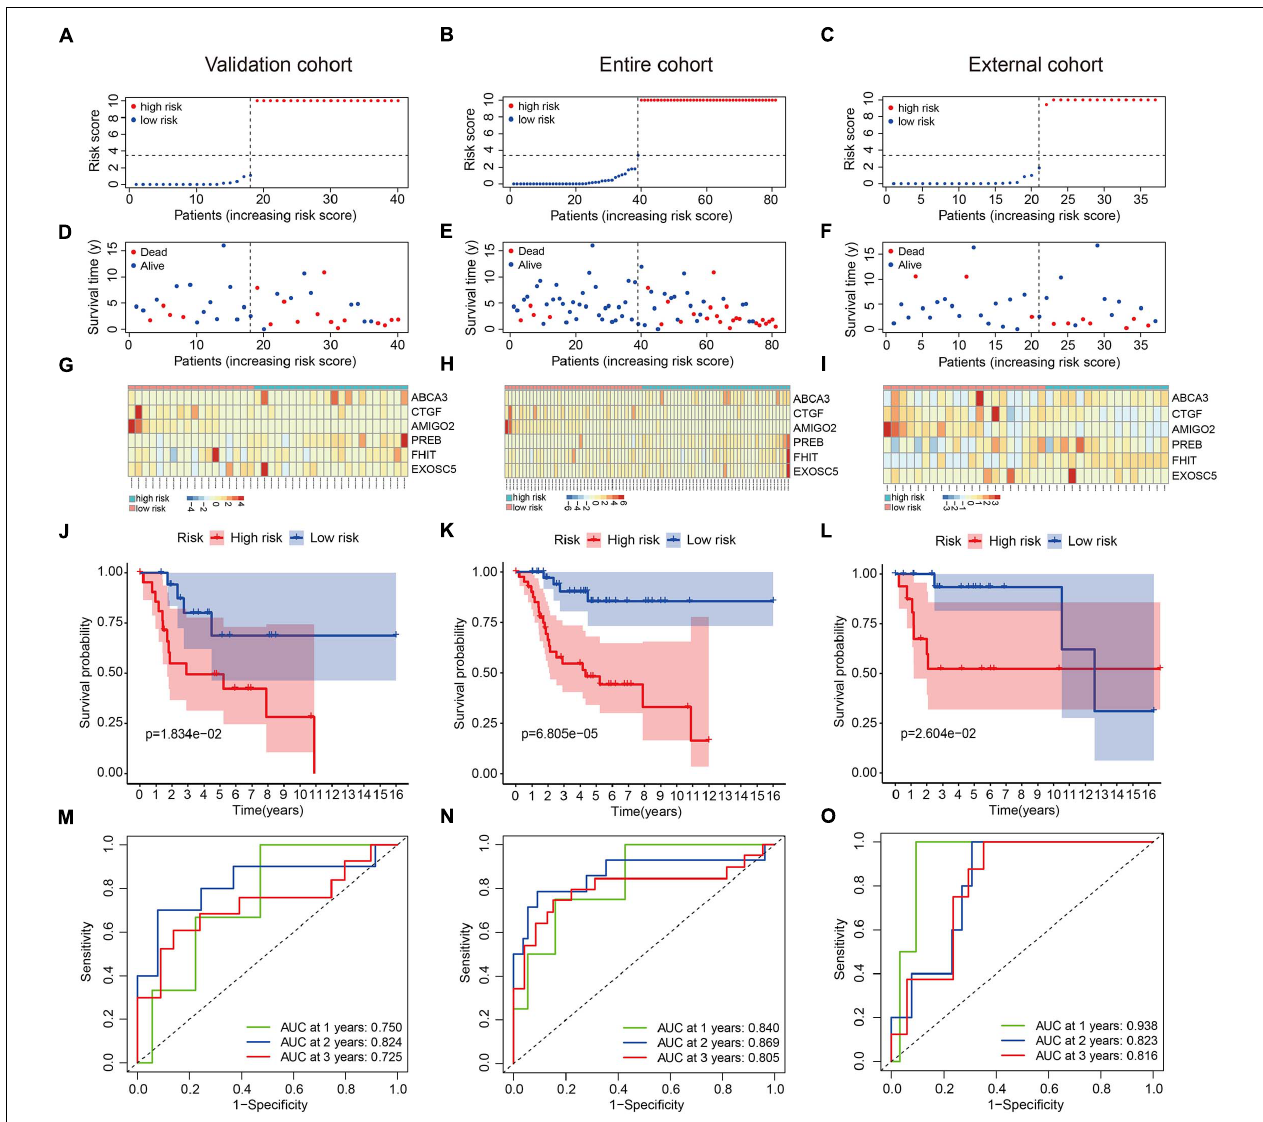
FIGURE 4 | Validation of the six-MRG prognostic model in the internal and external cohorts. (A–C) The risk score distribution of patients in the validation cohort, entire cohort, and external cohort. (D–F) The survival status of osteosarcoma patients in the three cohorts. (G–I) The mRNA expression profiles of the six MRGs in the three cohorts. (J–L) Kaplan-Meier survival analysis of patients in the three cohorts. (M–O) ROC curve analysis of the six-MRG signature in the three cohorts.